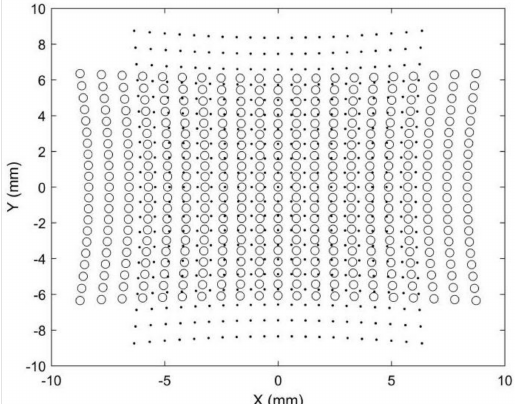
Figure 4. Simulated image points on the image plane. The dot points refer to the image points when the anamorphic lens is in the vertical position, and the circle points refer to the image points when the anamorphic lens is in the horizontal